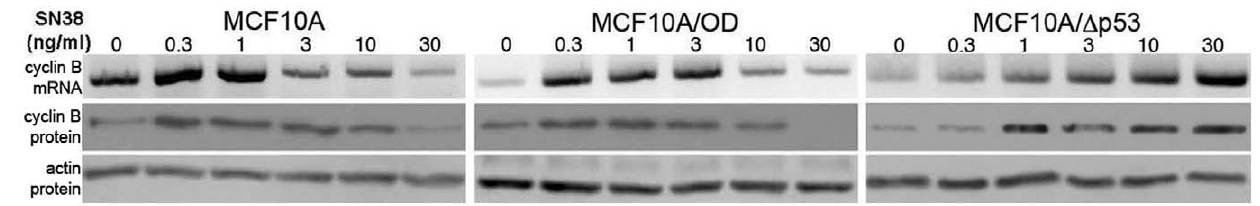
Figure 2. Determination of cyclin B mRNA and protein levels. MCF10A, MCF10A/OD, and MCF10A/ D p53 cells were incubated with 0–30 ng/ ml SN38 for 24 hours. RNA was purified from cell lysates and relative levels of cyclin B mRNA were analyzed using RT-PCR followed by agarose gel electrophoresis. Cell lysates were also analyzed for expression of cyclin B and actin protein using SDS-PAGE followed by immunoblotting with cyclin B- or actin-specific antibodies.